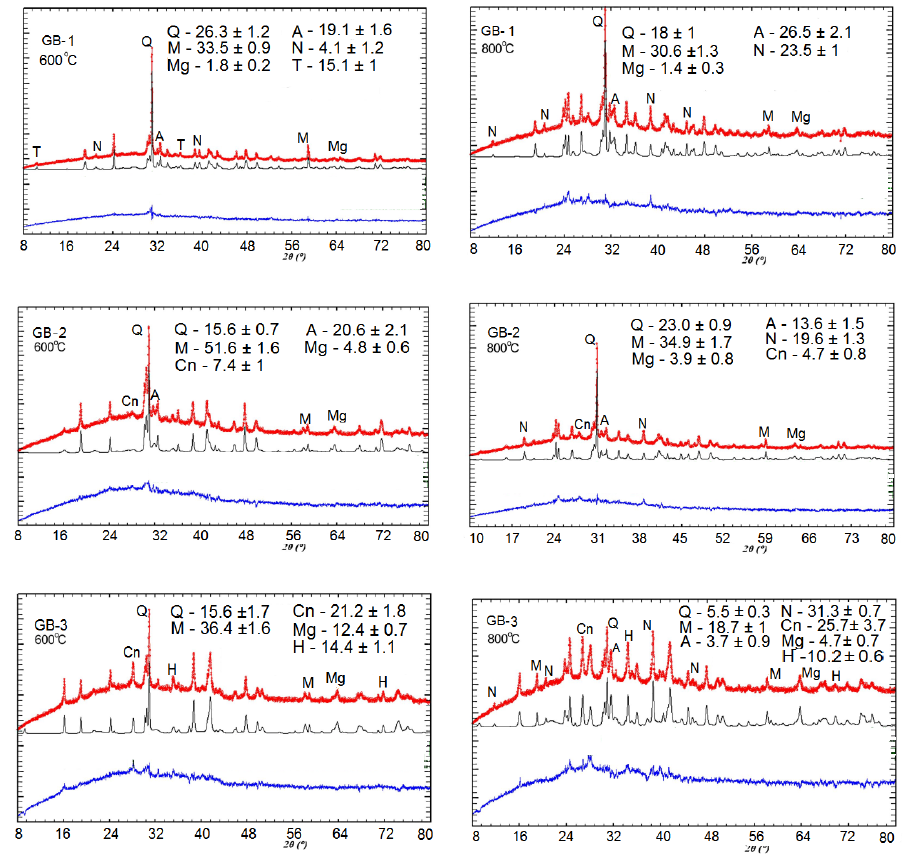
Figure 3. Quantitative Rietveld refinement of XRD patterns for alkali-activated binders at 600 ◦ C and 800 ◦ C of thermal exposure (Q, quartz; M, mullite; Mg, magnetite; H, hematite; A, anorthite; N nepheline; T, trona; Cn, cancrinite). Here, red line is for theoretical profile; black line is for experimental profile; and blue line represents the di ff erence between the theoretical and experimental